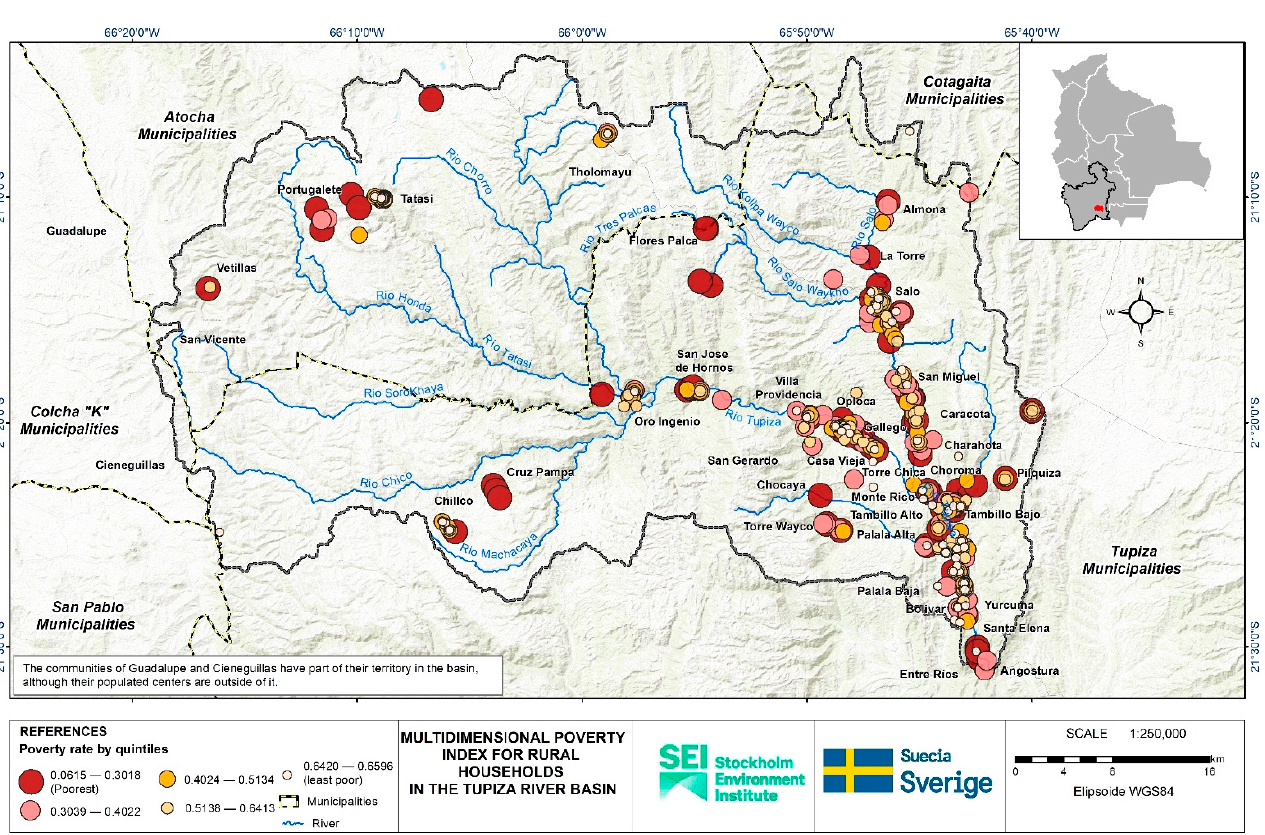
Figure 2. Multidimensional Poverty Index for rural households of the Tupiza river